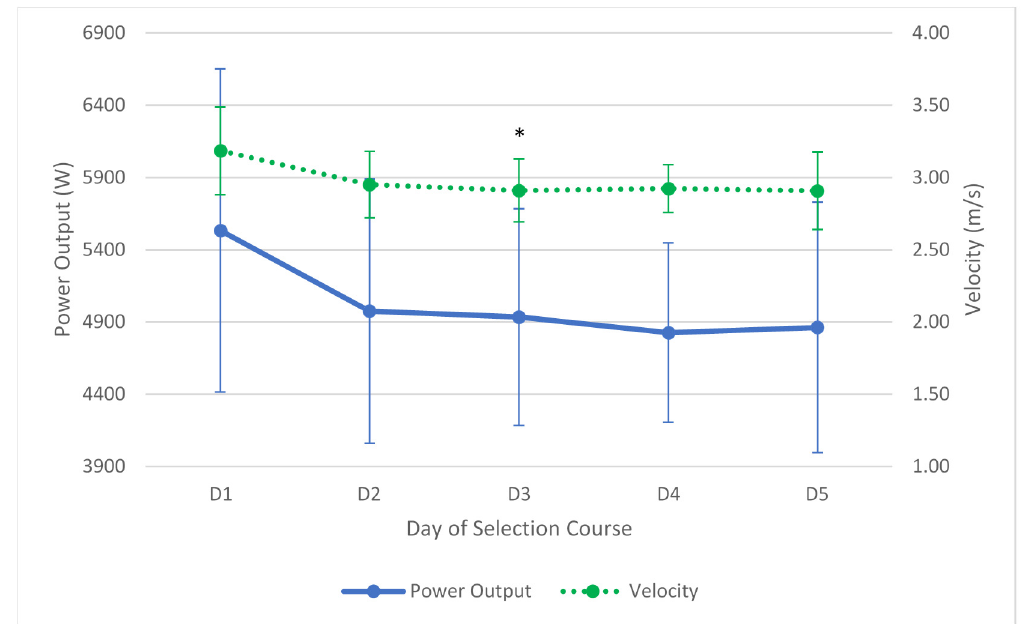
Figure 5. Average changes (±SD) in vertical jump performance over the five days. Solid line represents power output, dotted line represents velocity. * = Significant decrease in jump velocity compared to day one ( p < 0.05).